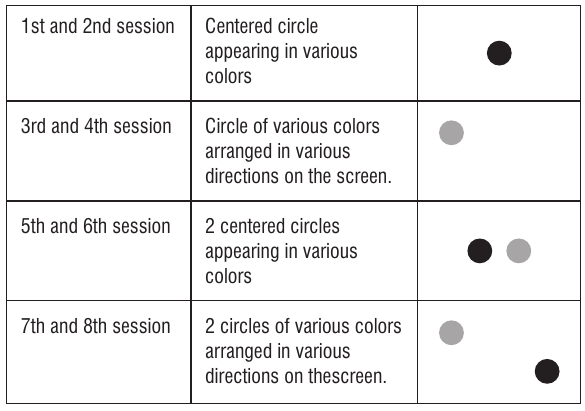
Figure 1 - Visual attention training protocol used in conjunc- tion with walking on a treadmill (dual task) Source: Research data.